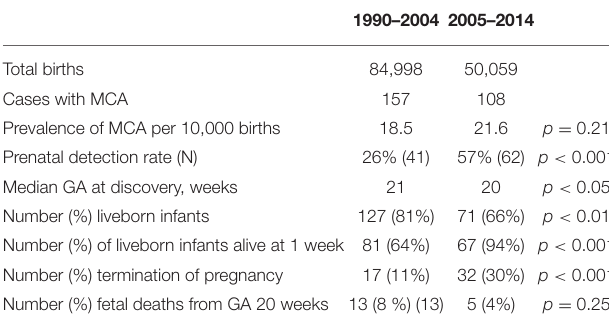
TABLE 1 | Prevalence of multiple congenital anomalies, prenatal detection rates, and outcomes of